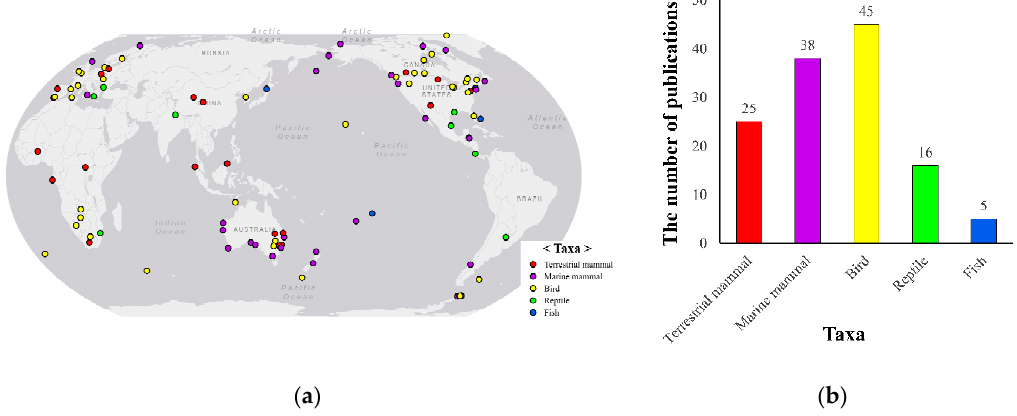
Figure 2. Global areas with RPAS wild animal monitoring and the number of publications. ( a ) Areas where RPAS monitoring has been applied and ( b ) the number of publications by animal taxa.